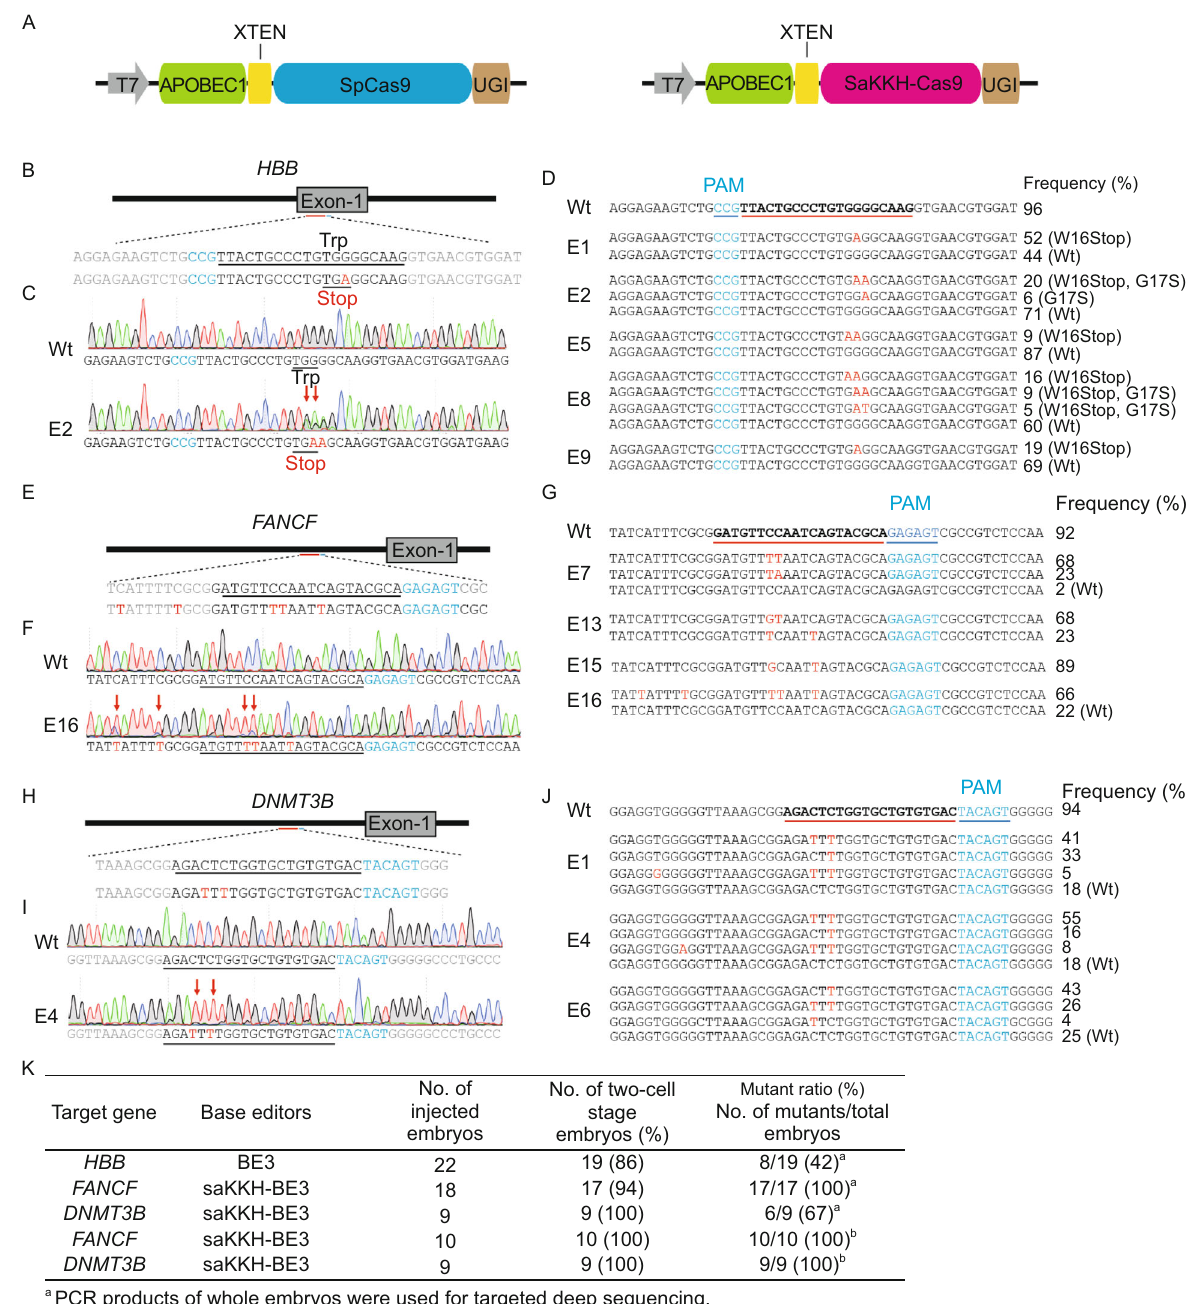
( FANCF -E20, E24) and two DNMT3B base-editing embryos ( DNMT3B -E11, E14) contained only targeted point mutations (Figs. S3 and S4). C-to-T conversion was the major muta- genic pattern, and C-to-A or C-to-G conversions were also observed in FANCF and DNMT3B mutant embryos (Fig.